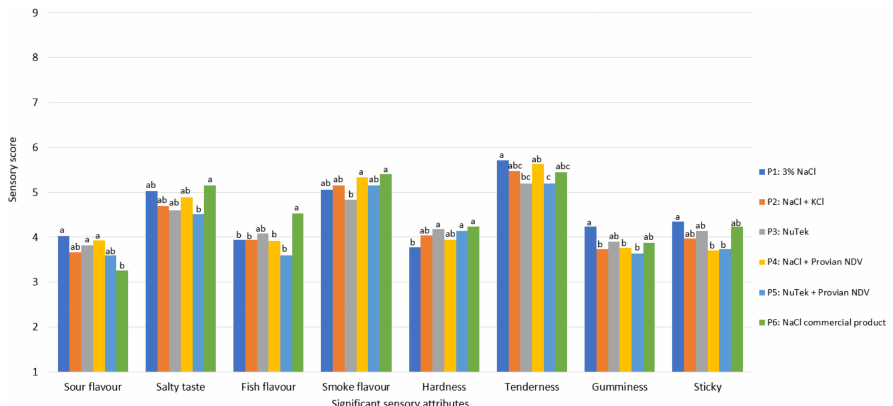
Figure 6. Sensory attributes indicating statistically significant differences after descriptive analysis of CS salmon produced with NaCl and added KCl and inhibiting salt proviant NDV (Products P1–P6). Letters above the columns indicate groupings according to the TUKEY’s HSD test at significance level p < 0.05. Samples with the same letter are considered being equal for the specific sensory attribute.